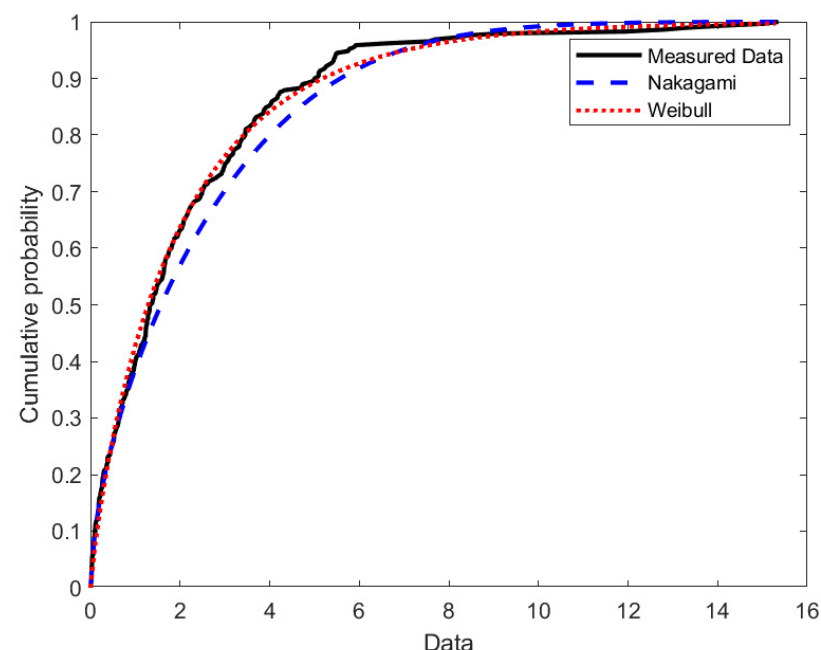
Figure 8. Cumulative distribution functions fitting fast variations within the corridor at 3.5 GHz in NLoS